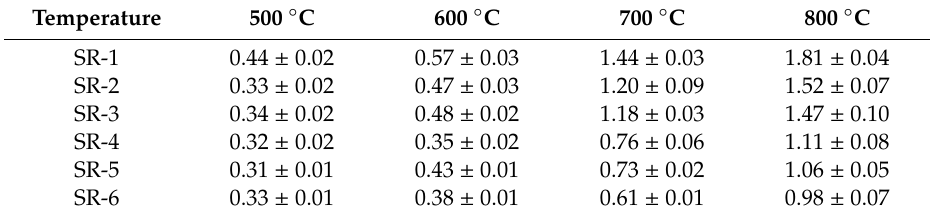
Table 2. Sum of masses of gaseous products emitted from the combustion of composites, g / g of sample. Temperature